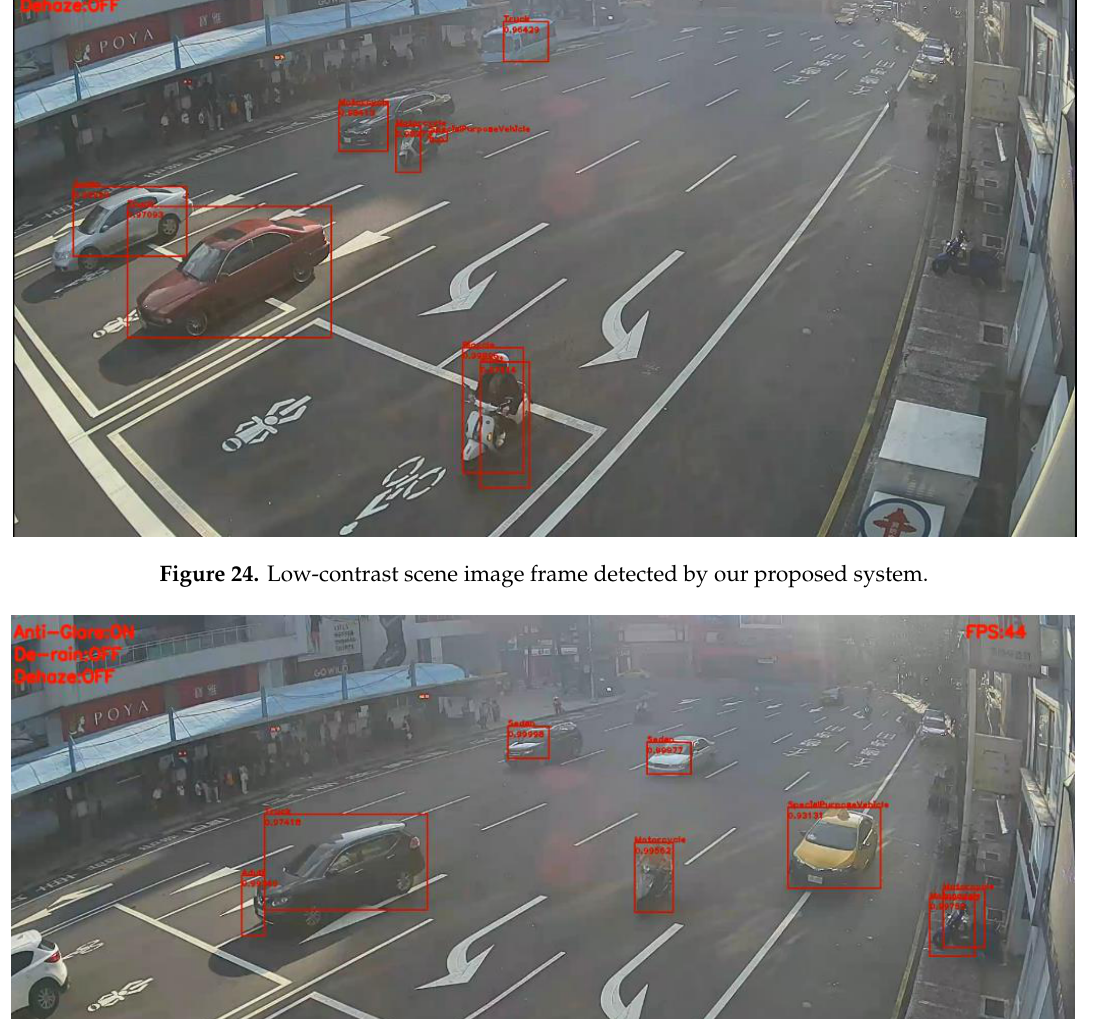
Figure 23. Low-contrast scene image frame detected by YOLOv3.